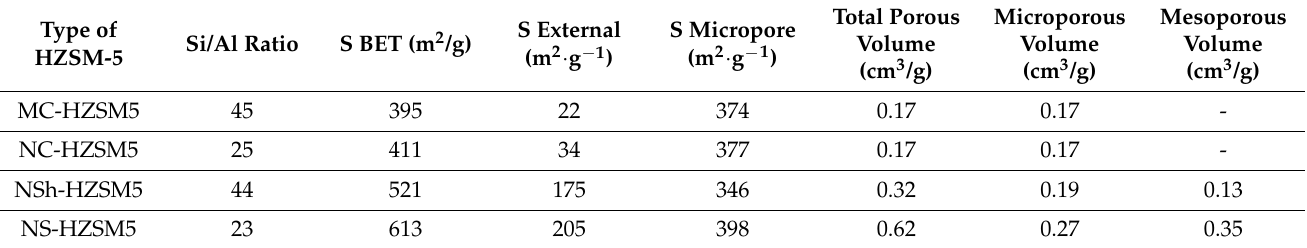
Table 1. Characteristics of the different HZSM-5